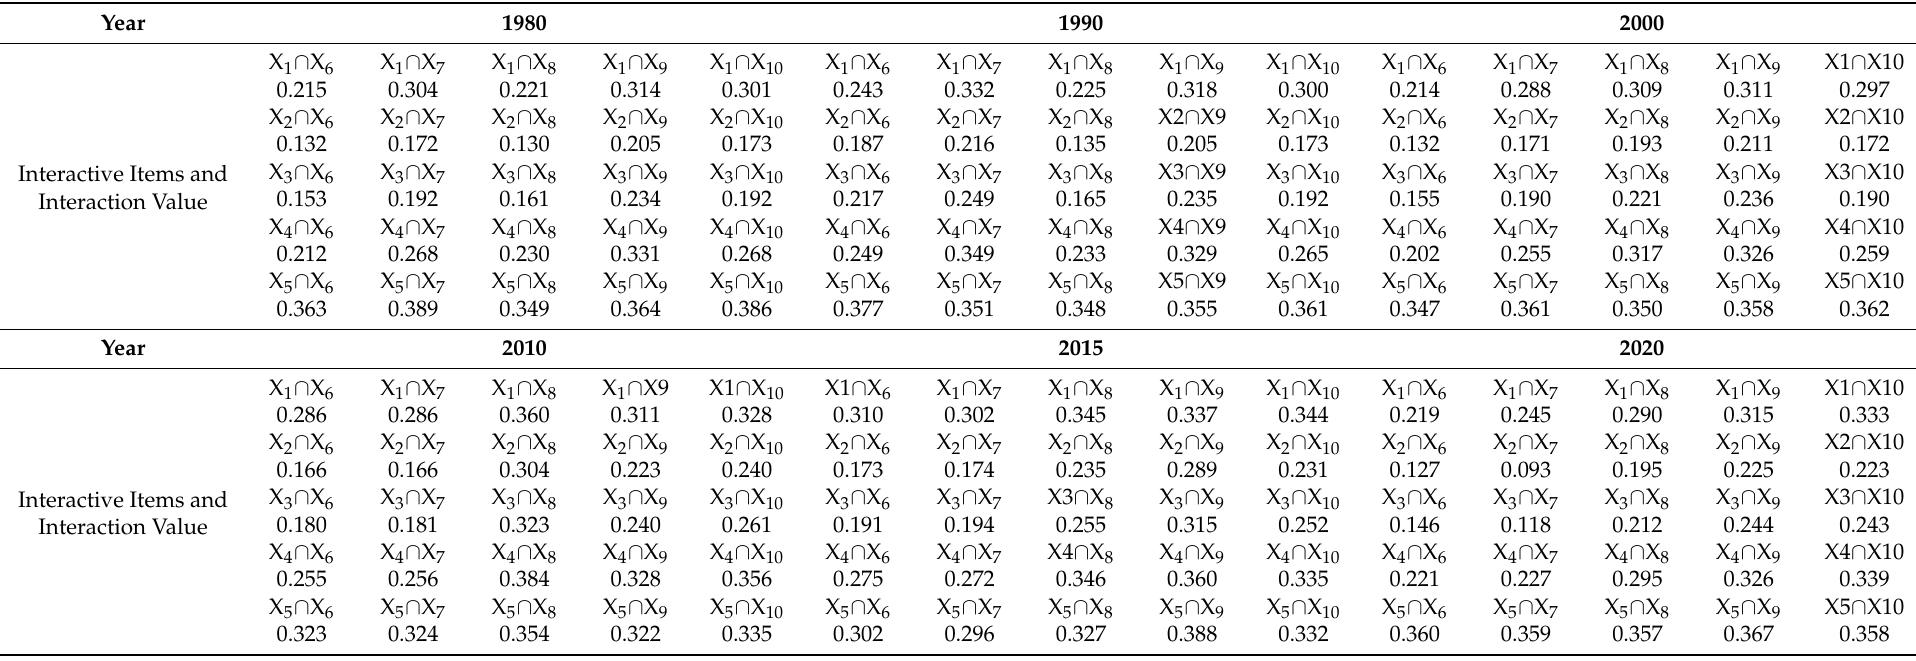
Table 7. The interaction of natural and human factors on the driving force of eco-environmental quality evolution in Qinghai